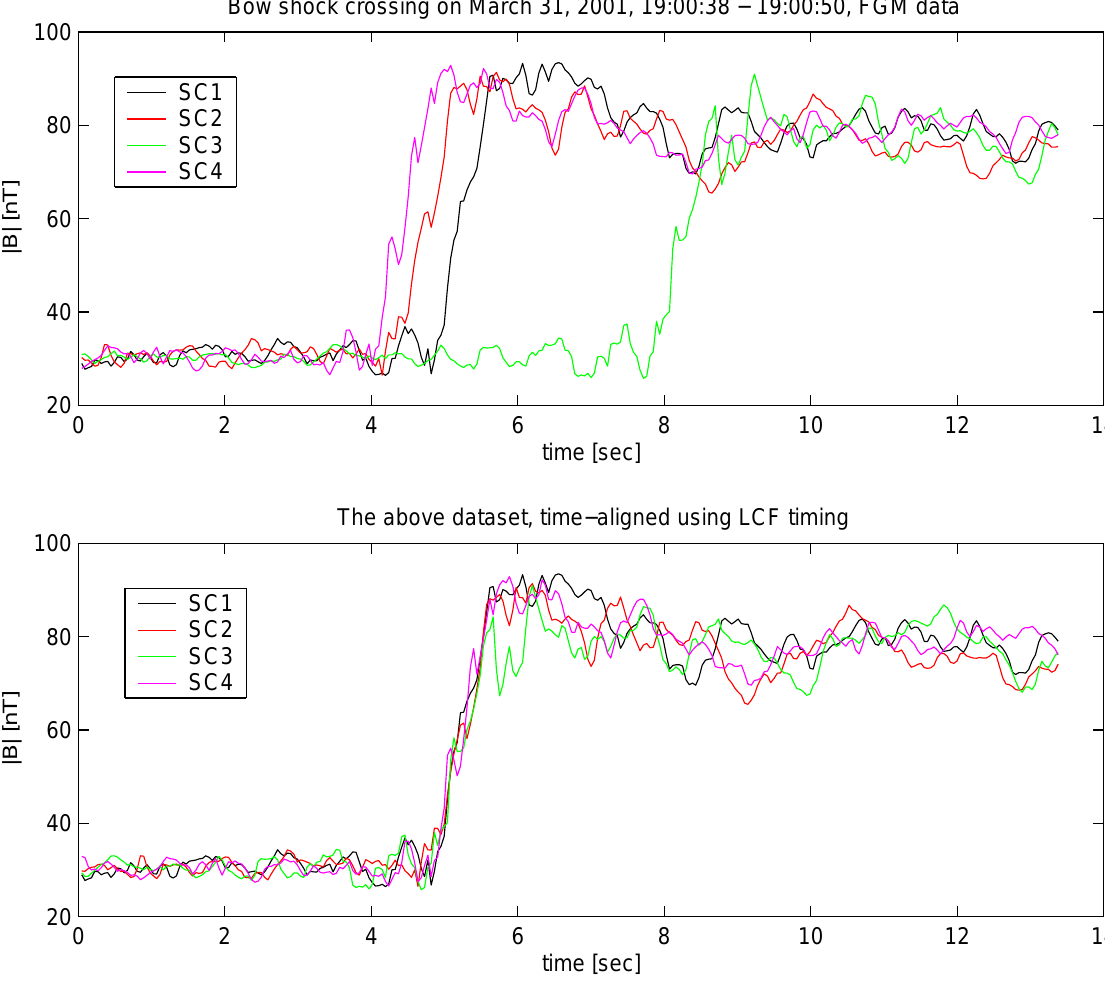
Fig. 5. A LWC analysis of a sharp, quasi-perpendicular bow shock crossing of 31 March 2001, from 19:00:38–19:00:50 UT. The upper panel shows a magnetic field magnitude observed by the FGM instrument on CLUSTER during the bow shock crossing. The bottom panel shows the same data but with the shock fronts shifted by the lags obtained from the LWC. The sampling frequency of the magnetic field data is